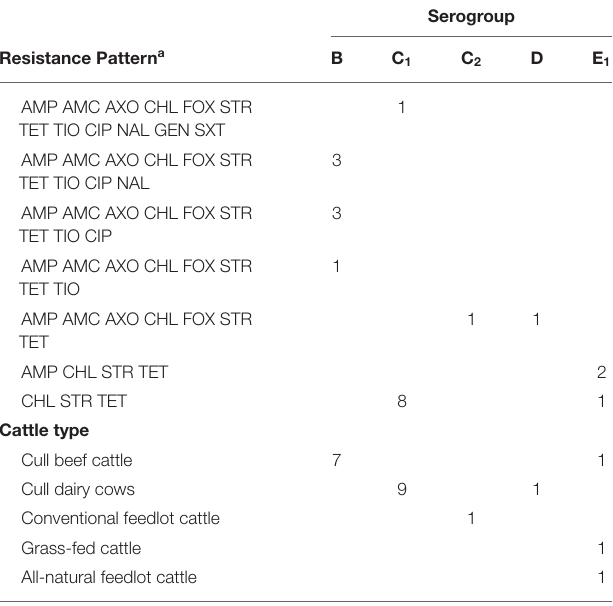
TABLE 4 | Multi-drug resistant Salmonella isolates by serogroup isolated from subiliac lymph nodes ( n = 4) and feces ( n = 17) of cattle, by antimicrobial resistance pattern and